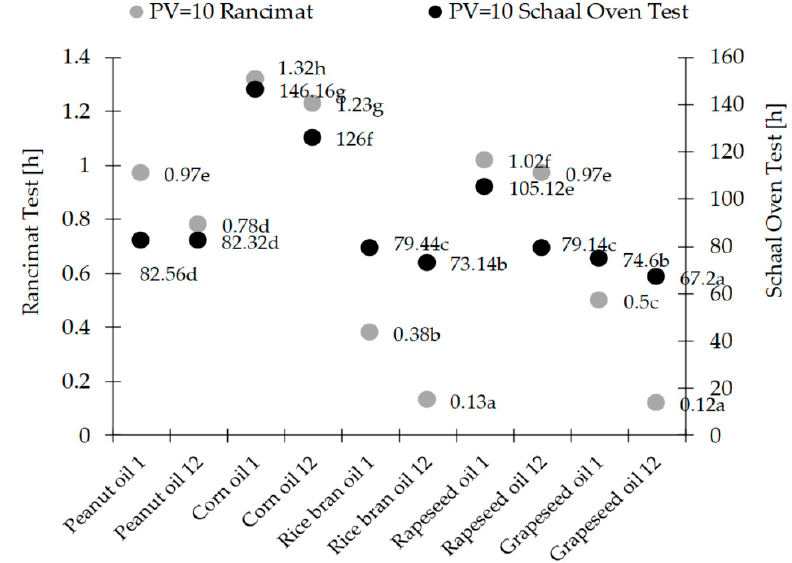
Figure 5. Time to reach peroxide (PV) = 10 in selected oils in the Rancimat and Schaal Oven Test in the 1st and 12th months of storage. Different small letters indicate statistically significant differences at the level p < 0.05 between oils in one test.